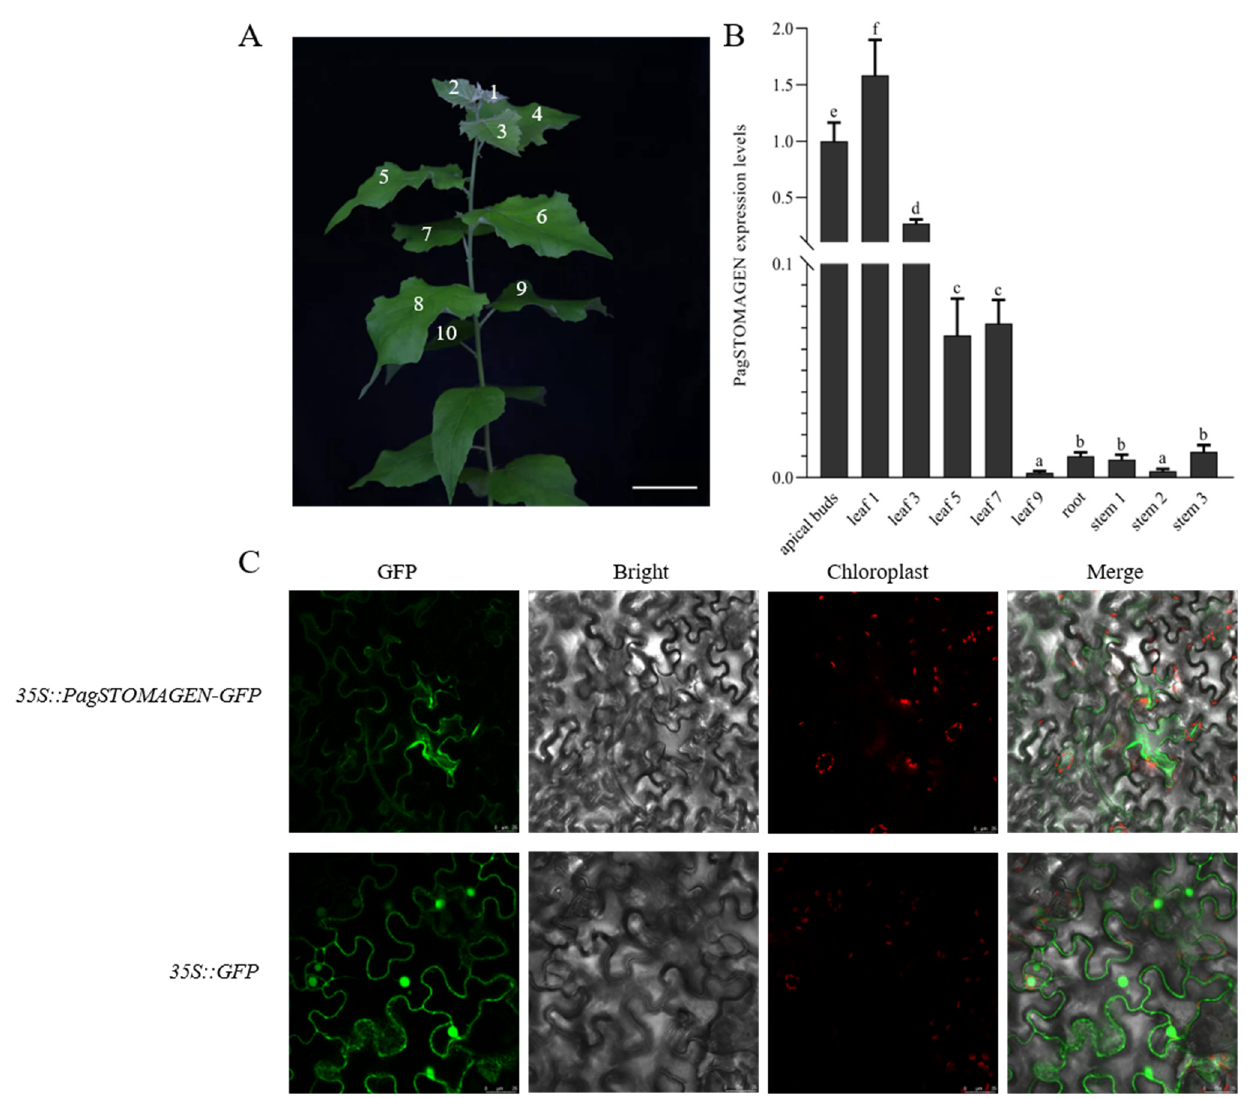
Figure 2. Expression patterns and subcellular protein localization of PagSTOMAGEN . ( A ) Definition of leaf numbers. Bar = 5 cm. ( B ) Expression patterns of PagSTOMAGEN in different tissues. PagACTIN was used as a reference. Error bars represent the standard deviations (SD) of three biological replicates. p < 0.05 was considered statistically significant and is represented by different letters. ( C ) Subcellular localization of the PagSTOMAGEN protein. Laser confocal microscopy was used to obtain images of tobacco leaves with transient expression of 35S::PagSTOMAGEN-GFP and 35S::GFP . Bars = 25 μ m.